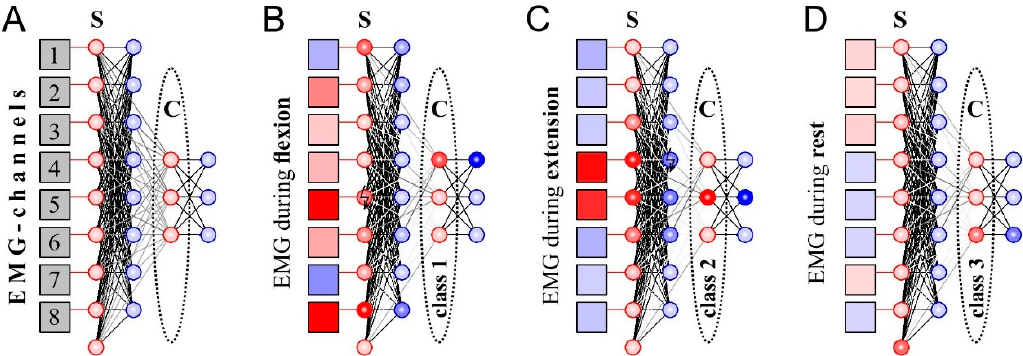
Figure 5. The scheme of spiking neuron networks (SNN) classifying EMG-patterns: ( A ) General topology of SNN; ( B – D ) The responses of SNN to EMG patterns during wrist flexion / extension / rest. Squares—EMG-associated virtual electrodes, red / blue circles—excitatory / inhibitory neurons. The color saturation of red / blue is proportional to the value of the positive / negative output signal of the corresponding circuit element at the moment. S—sensory neurons, C—classifying neurons.